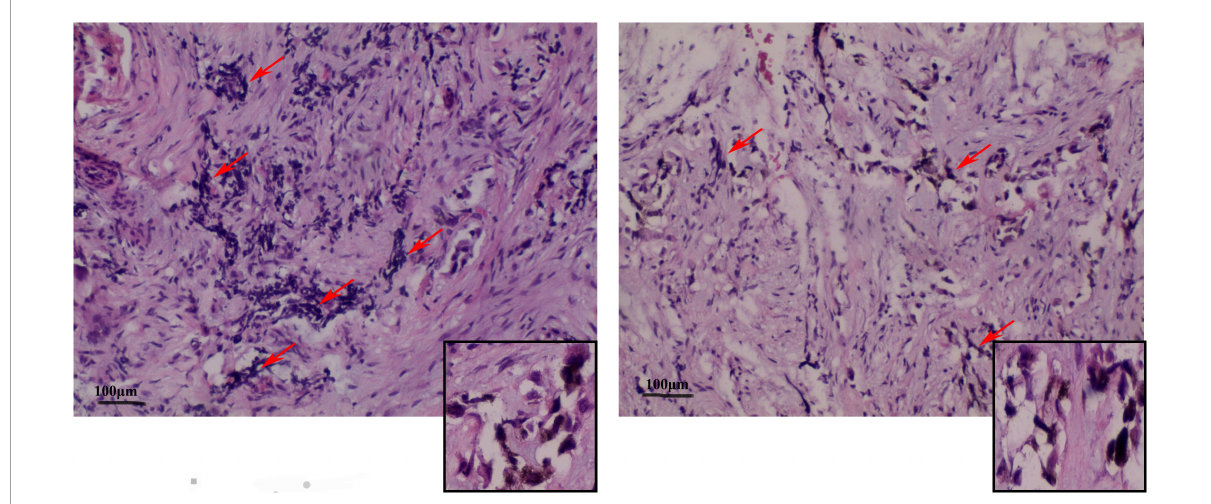
FIGURE3 Representative image ( × 100) shows the histopathological analysis of the tumor tissue. The tumor tissue consists mainly of neuroblastoma-like cells and melanin-containing epithelial cells. (Left) The small round or square and primitive neuroblastoma-like cells are large and contain melanin granules in the cytoplasm of the epithelial cells. The deep-stained and shrunken neuroblastoma-like cells are mostly arranged in nests with extruded nuclei. (Right) Pigmented epithelioid cells with vacuolated nuclei are observed in the large area surrounding the neuroblastoma-like cells. Some areas are mainly composed of pigmented epithelioid cells arranged in sheets, nests, or beam bundles, with dense fibrous connective tissue between the nests of cells, and some areas can be seen as bone trabeculae with visible nuclear schizograms (0–2 per 10 high magnification fields).